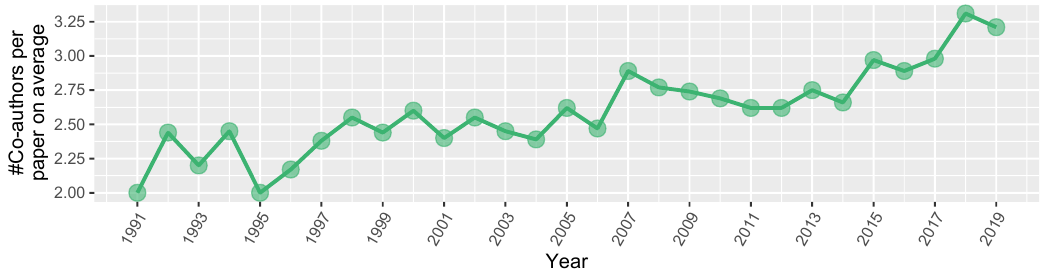
Figure 8. Evolution of the number of co-authors per paper on